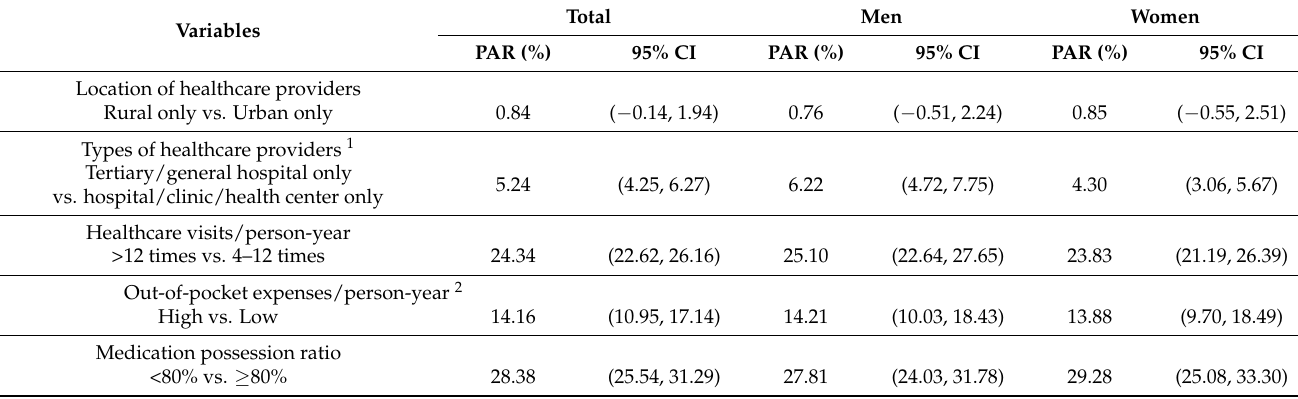
Table 4. Population attributable risks of increased ischemic heart disease risk according to healthcare utilization and medication